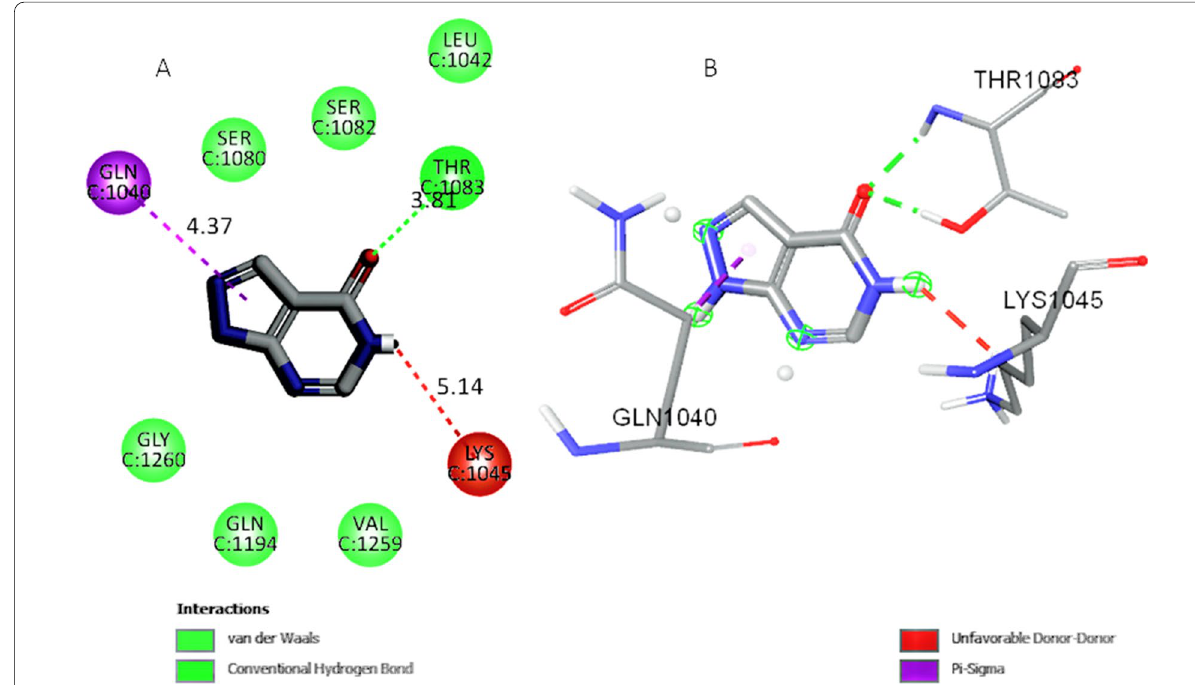
Fig. 6 2D ( A ) and 3D ( B ) simulations of allopurinol–XOD active site supramolecular bondings, showing a conventional hydrogen bond (with THR1093) and a pi-sigma bond interaction (with GLN1040) that are neither of substrate binding nor of catalytic importance